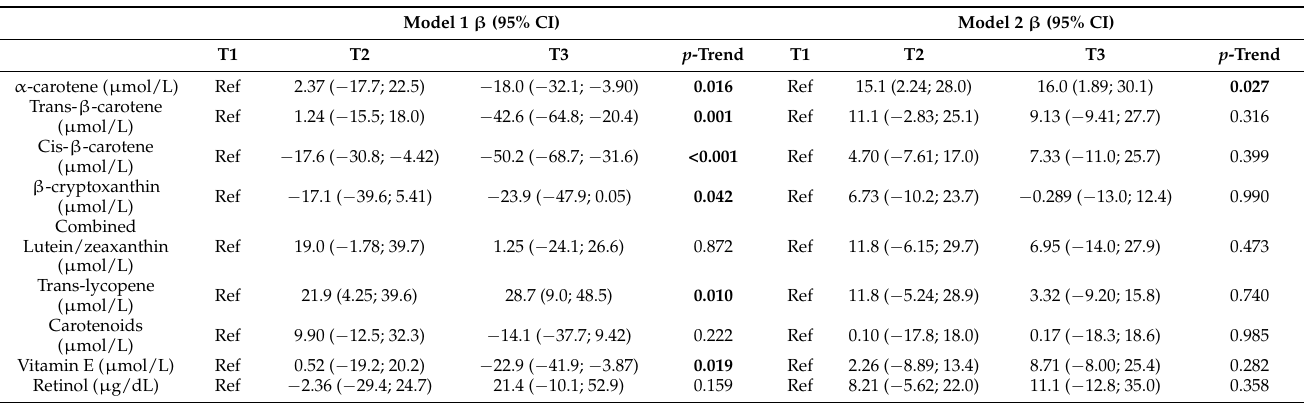
Table 2. Linear regression between tertiles of serum antioxidants and muscle strength. NHANES,